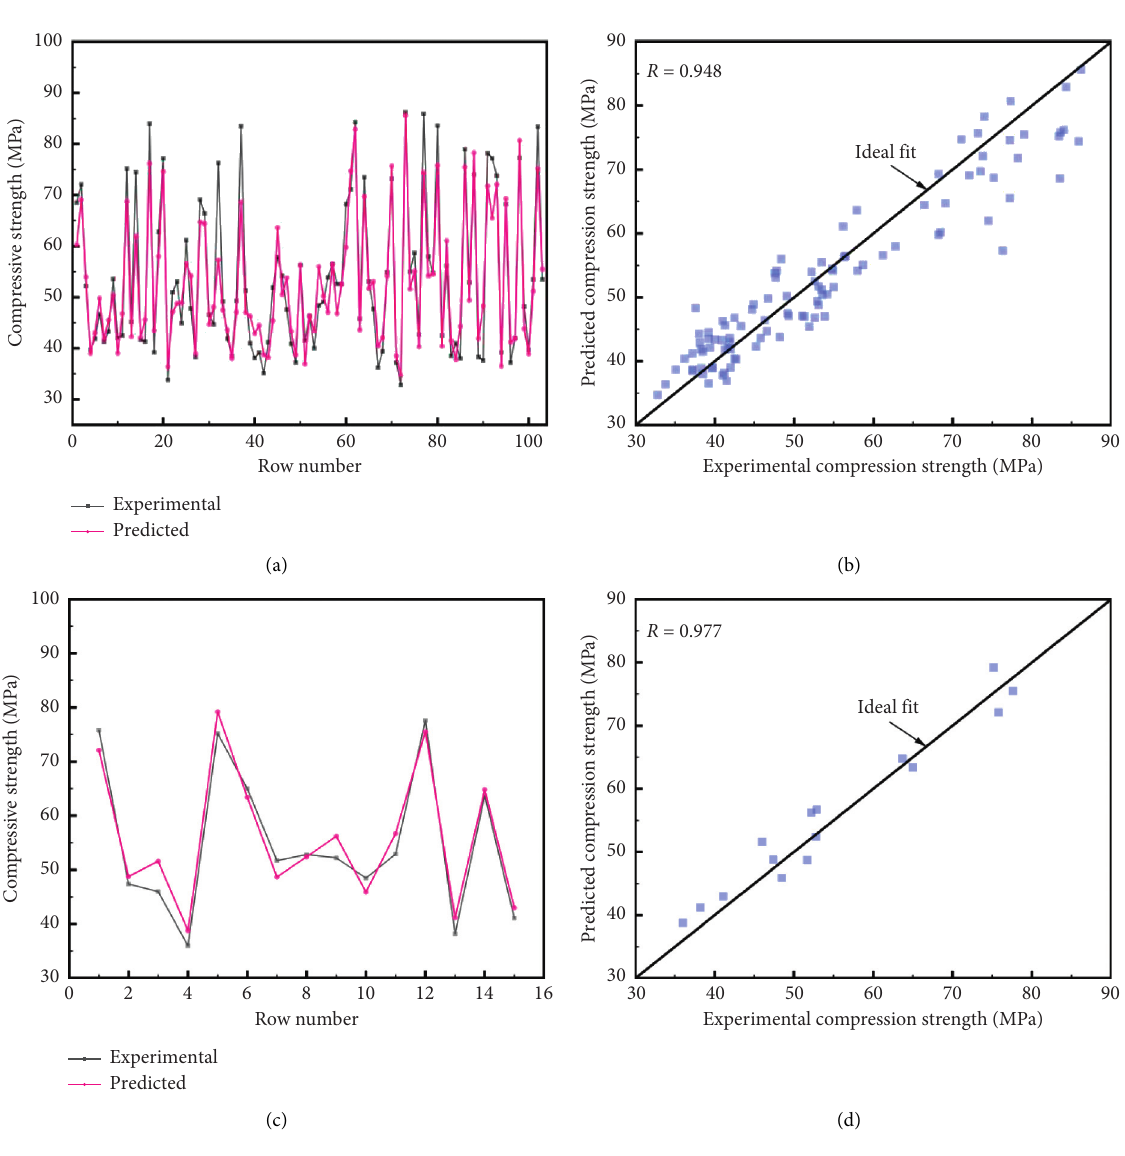
Figure 5: Comparison of predicted and experimental values. (a, b) Comparison on the training set. (c, d) Comparison on the testing